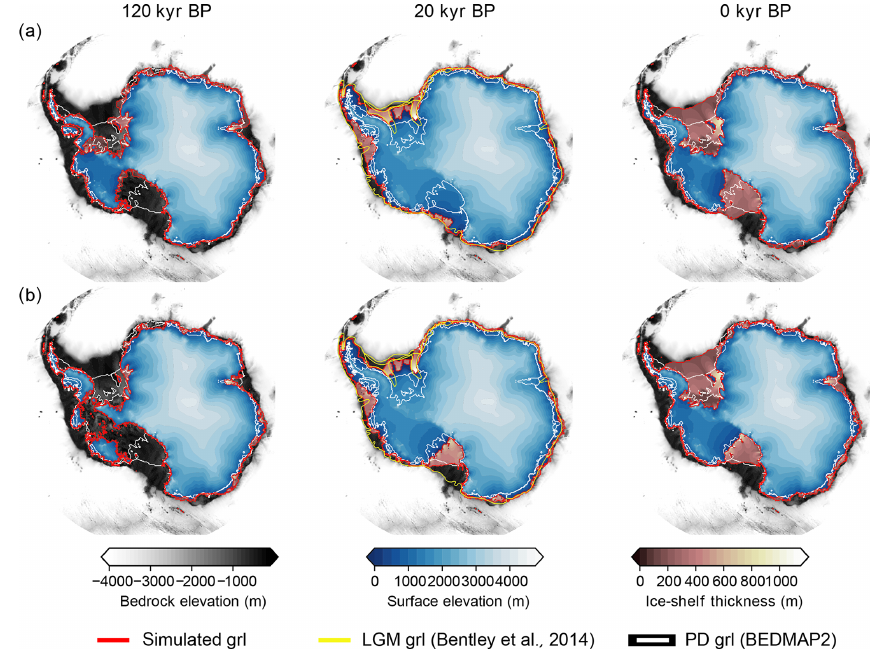
Figure 7. Panels (a–b) illustrate simulated ice-sheet configurations for the LIG, LGM and PD, respectively. Both simulations are carried out with forcing B1, using a different ice thickness calving limit ( a : cH=75m, b : cH=150m). Reconstructed grounding line positions for the LGM (Bentley et al., 2014) are depicted in yellow. Both grounding line and ice-shelf front from BEDMAP2 (Fretwell et al., 2013) are depicted in